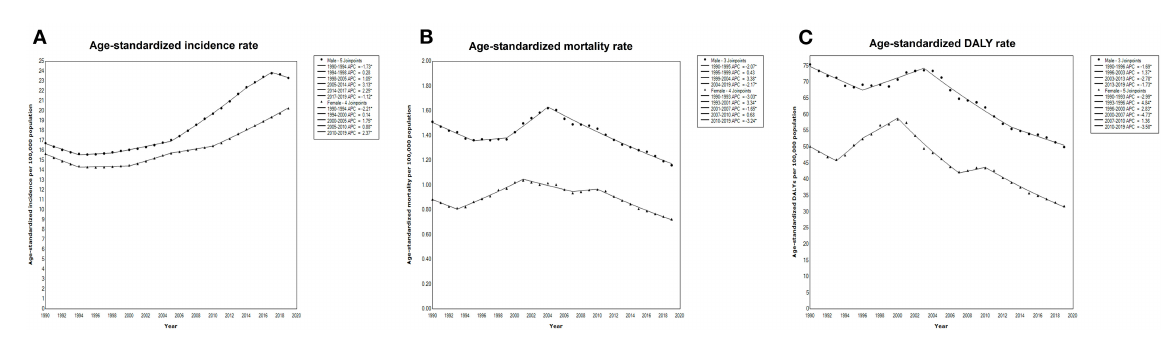
significant decrease in the ASMR and age-standardized DALYs (Figure